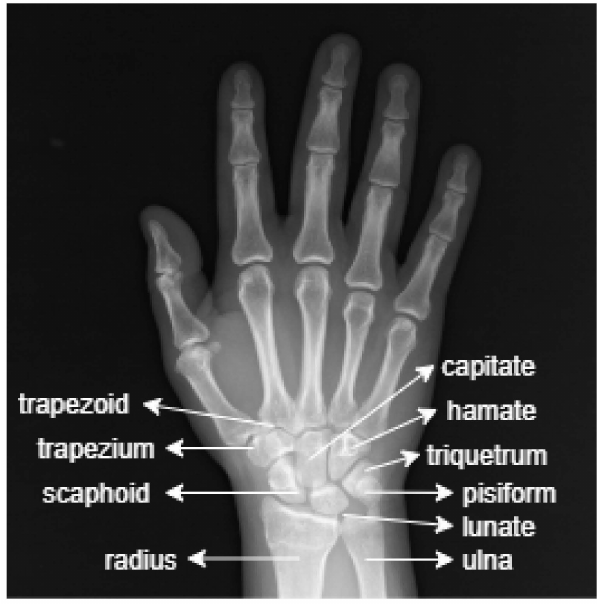
Figure 1. The anatomy of the